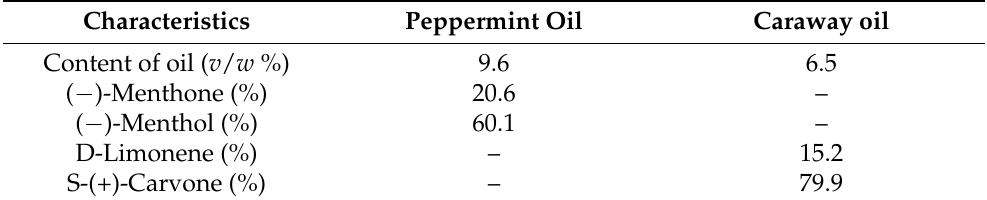
Table 3. Content and main compounds of peppermint and caraway essential oils in the microcapsules with maltodextrin as a